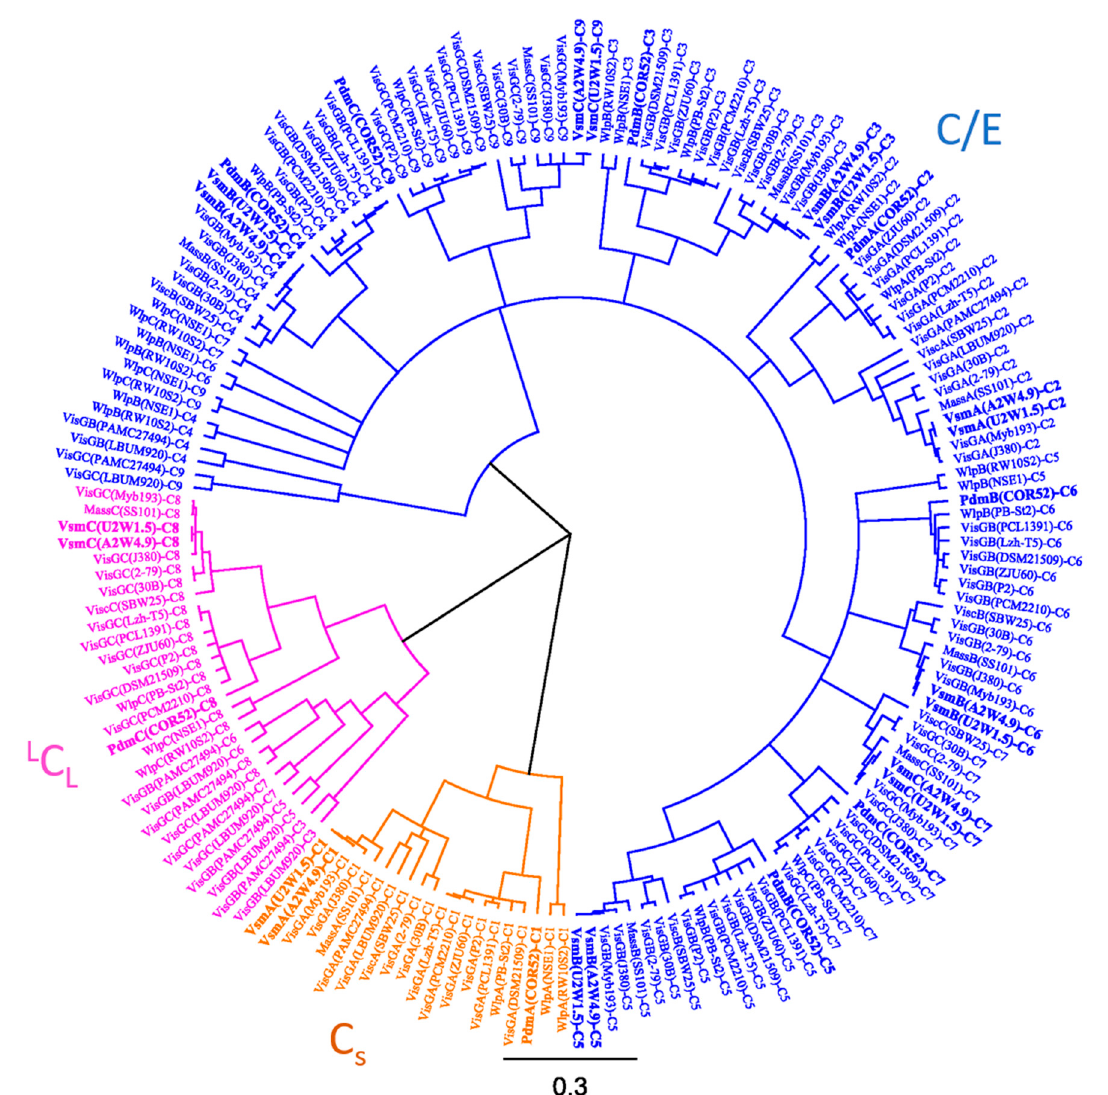
Figure A3. Phylogeny-based analyses of 180 condensation (C) domains extracted from NRPSs belonging to the Viscosin group. Cladogram of a maximum likelihood tree inferred from the amino acid sequence alignment of C domains extracted from functionally characterized and select putative Pseudomonas NRPSs. Lipopeptide-specific codes used for NRPS enzymes: Pdm (pseudodesmin, Pseudomonas sp. COR52, highlighted in bold font); Vsm (viscosinamide, Pseudomonas sp. A2W4.9 and Pseudomonas sp. U2W1.5, highlighted in bold font); Wlp (white line inducing principle, Pseudomonas sp. NSE1, P. putida RW10S2, P. chlororaphis Pb-St2); Mass (massetolide, P. lactis SS101); Visc (viscosin, P. fluorescens SBW25); VisG (Viscosin group, not characterized: Pseudomonas sp. Myb193, Pseudomonas sp. J380, P. synxantha 30B, P. synxantha 2-79, P. antarctica PAMC 27494, Pseudomonas sp. LBUM920, P. chlororaphis subsp. piscium PCL1391, P. chlororaphis subsp. aurantiaca PCM 2210, P. chlororaphis subsp. aureofaciens P2, P. chlororaphis subsp. piscium DSM 21509, P. chlororaphis subsp. piscium ZJU60 and P. chlororaphis Lzh-T5). For each domain, the substrate specificity is indicated in parentheses, using the standard amino acid three-letter code. VisGA, VisGB, VisGC represent NRPS enzymes for viscosin-group CLPs that have been characterized based on genome mining only. The phylogenetic tree was drawn using the Geneious 11.1.5 software. Clusters are shown according to the type of C domains in color; N -acylating C s starter domains (orange), conventional L C L domains (pink), dual condensation/epimerization domains (blue). The phylogenetic tree was drawn using the Geneious 11.1.5 software.